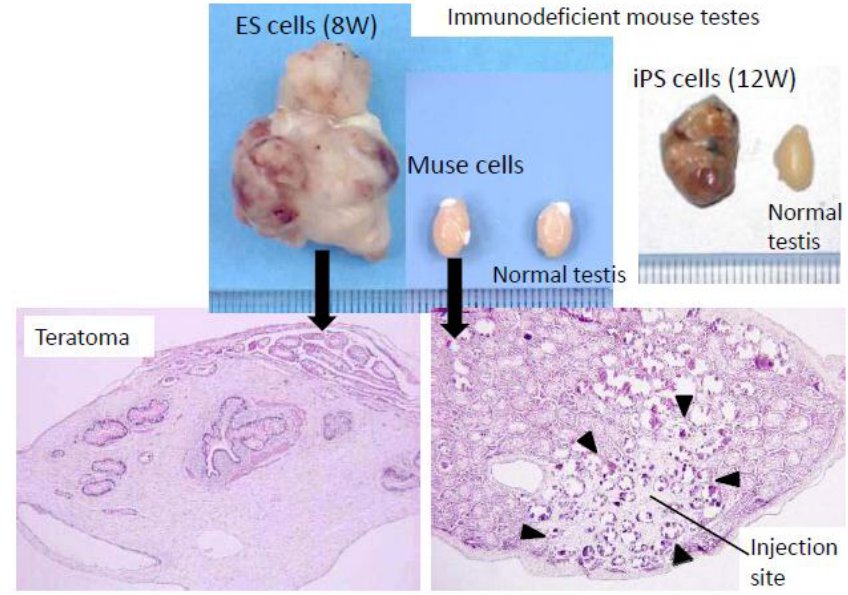
Figure 3. Non-tumorigenic properties of Muse